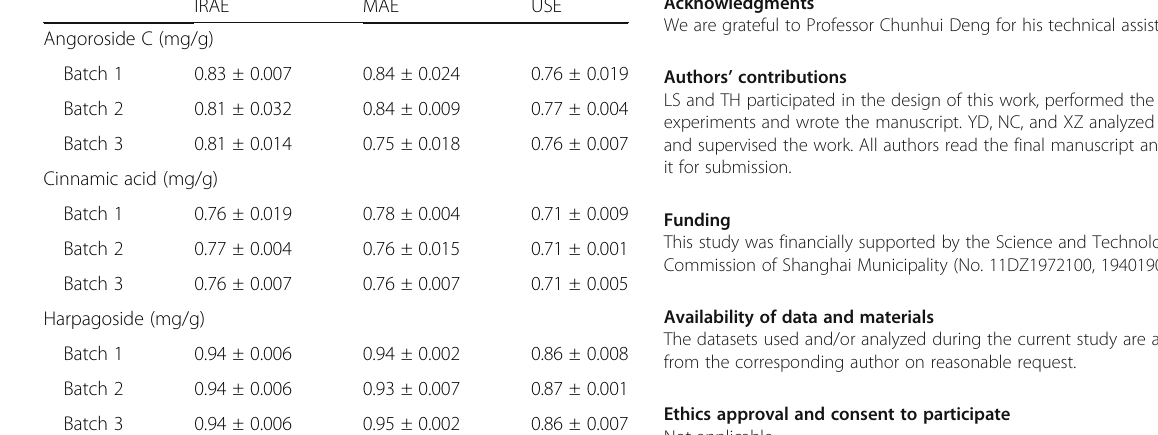
Table 3 The concentrations of angoroside C, cinnamic acid and harpagoside in S. ningpoensis samples using different extraction methods under their optimal conditions (mg/g ± SD, n = 3) IRAE MAE USE Angoroside C